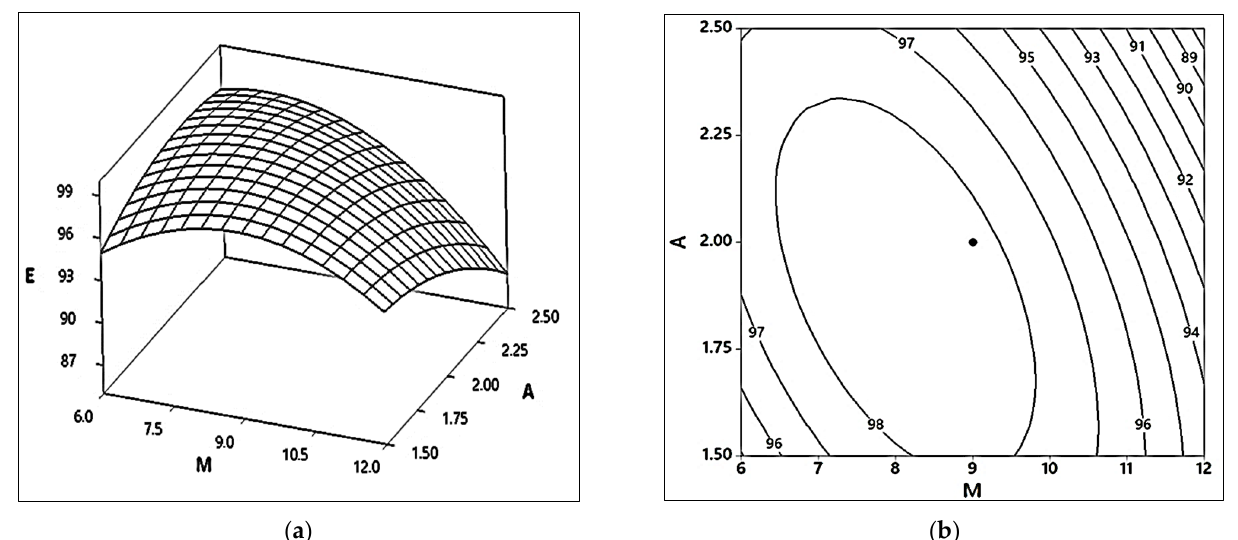
Figure 2. Interaction effect of the methanol to oil molar ratio and acid catalyst content on the acidity removal of the WCO esterification process. ( a ) A 3D response surface plot of E (%) vs. M (M) and A (wt.%). ( b ) A 2D contour plot between M (M) and A (wt.%).